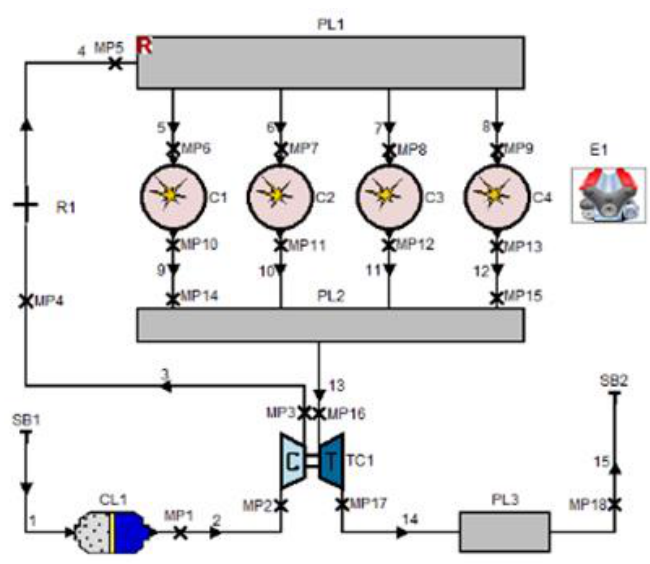
Figure 2. Digital Engine Model used in AVL BOOST.